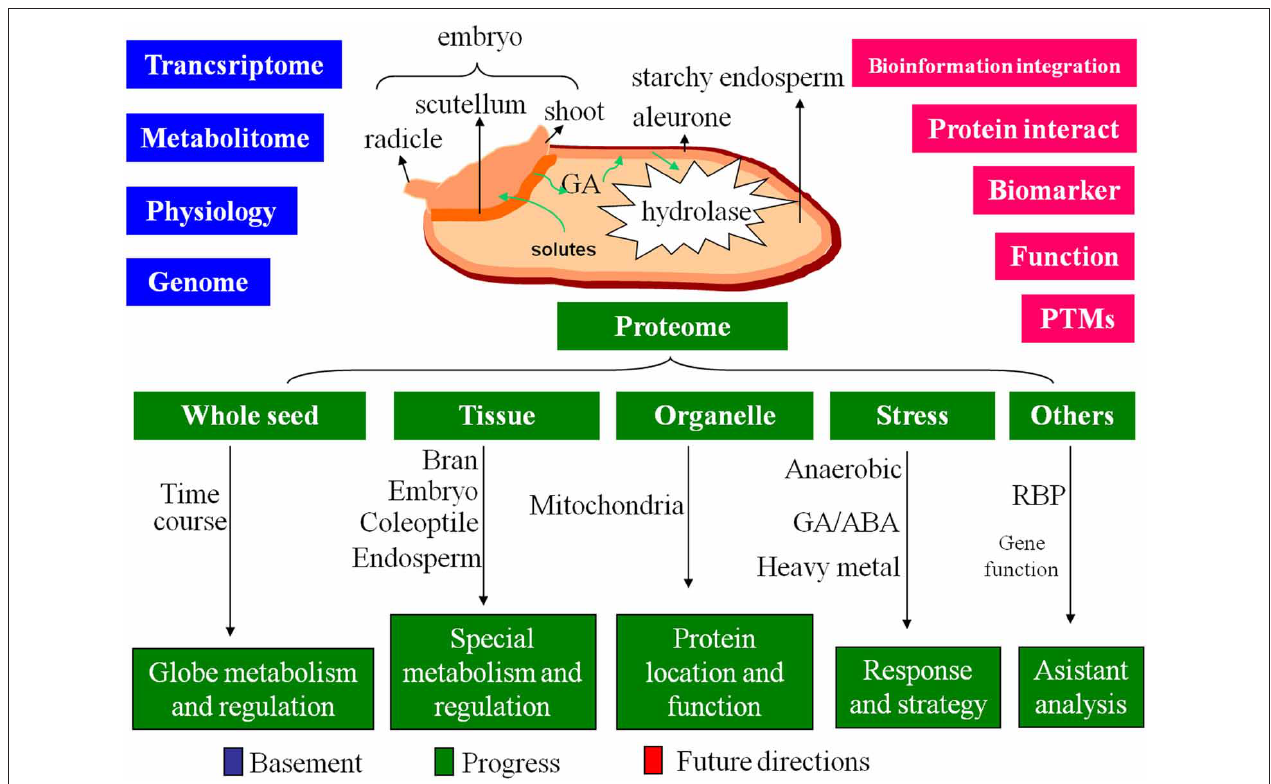
FIGURE 2 | The basement, progress and future directions of the proteome on riceseed germination. Basedon thegreat achievementsofthe genome, transcriptome, metabolitome and physiology, the proteome of rice